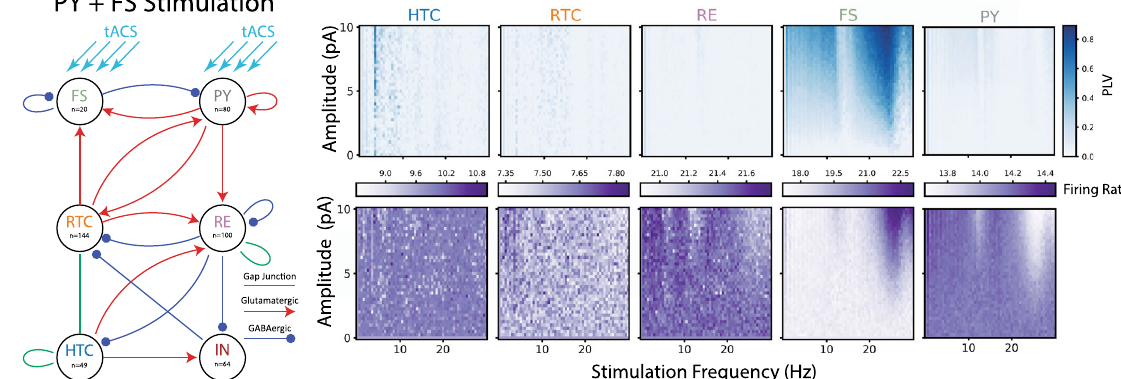
Fig. 7 Modeling tACS stimulation to both PY and FS Cells. Phase-locking (top) and fi ring rate (bottom) response to tACS applied to both the PY and FS cells. Each pixel in the histogram represents fi ve seconds of simulation with the appropriate amplitude tACS stimulation. In the plot, tACS amplitude and frequency range from 0 to 10 pA and 0 to 30 Hz, respectively. The FS neurons exhibit two Arnold tongues, the fi rst centered around the endogenous frequency for the PY neurons, 13.5 Hz, and the second centered at the fi rst harmonic. For PY neurons, an Arnold tongue is also present at the endogenous frequency. Phase-locking for the FS neurons is high compared to the model where FS neurons were not stimulated, especially at the fi rst harmonic. In this plot, the high phase-locking in the FS neurons overshadows the Arnold tongue in the PY neurons, but it is still